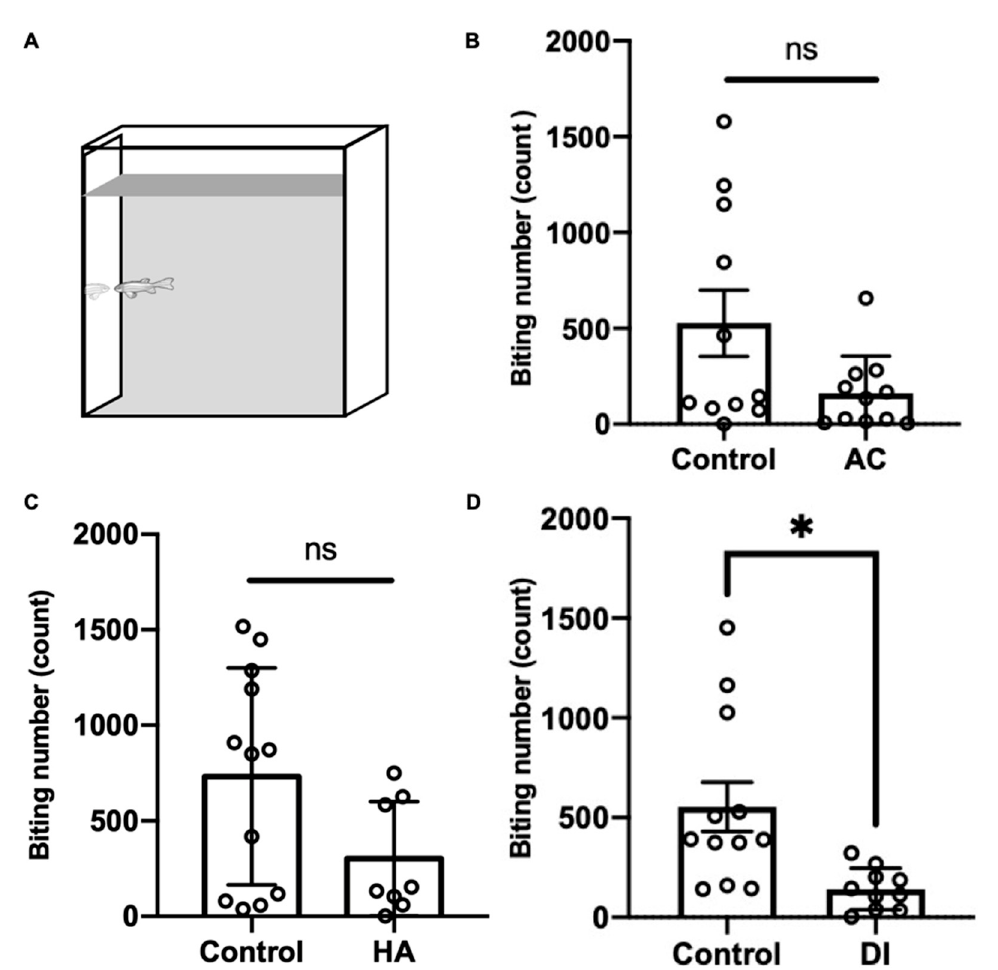
Figure 7. Effects of AC, HA, and DI treatments in the mirror biting test. ( A ) Schematic of the mirror biting test. Adult zebrafish were exposed ( B ) AC, ( C ) HA, or ( D ) DI, and the mirror-biting frequency was determined. Each circle represents the data of one single fish. In AC treatment, n = 11 for control group; n = 10 for the treatment group. In HA treatment, n = 12 for control group; n = 8 for the treatment group. In DI treatment, n = 11 for control group; n = 10 for the treatment group. All the treatments reduced mirror-biting frequency relative to control fish. The asterisks (*) indicate significant differences between the control and treatment groups.; ns indicates that no significant difference was found between the control and treatment groups. Values are means ± SD in ( A ) and ( C ) ( p < 0.05 (Student’s t -test)). Values are means ± SEM in ( B ) ( p < 0.05 (Mann–Whitney)).